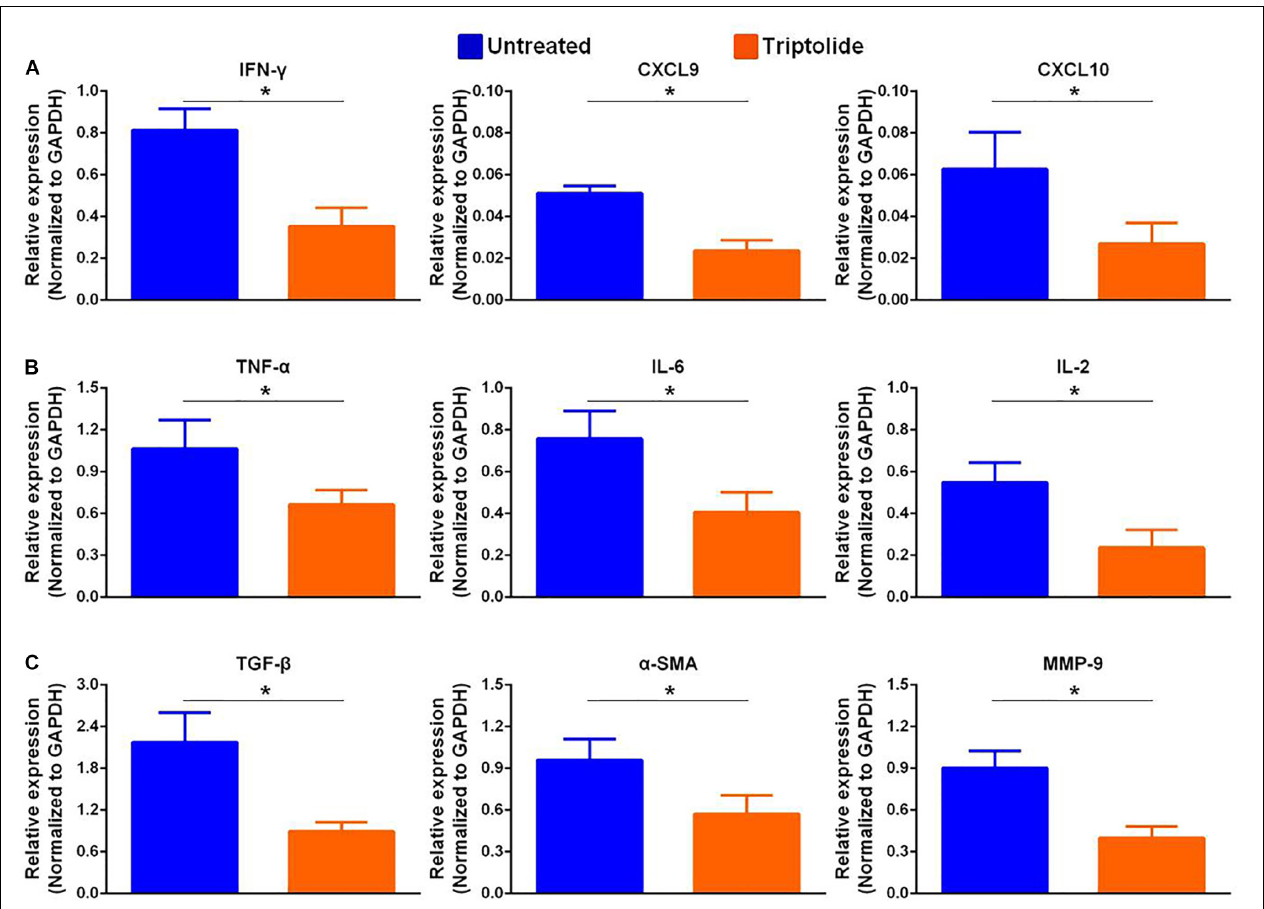
FIGURE 3 | Triptolide inhibits mRNA expression levels of pro-inflammatory and pro-fibrotic factors. Aortic allograft animals were treated with or without triptolide for 4 weeks after transplantation. The mRNA expression of (A) IFN- γ and IFN- γ –inducible chemokines ( CXCL9 and CXCL10 ), (B) inflammatory chemokines ( TNF- α , IL-2, and IL-6 ), and (C) pro-fibrotic factors ( TGF- β , α -SMA, and MMP-9 ) were determined by RT-PCR. The mRNA levels were normalized to that of GAPDH . Three independent experiments were performed and showed similar results. Data were expressed as mean ± SD. * p < 0.05 vs. untreated Student’s t- test.